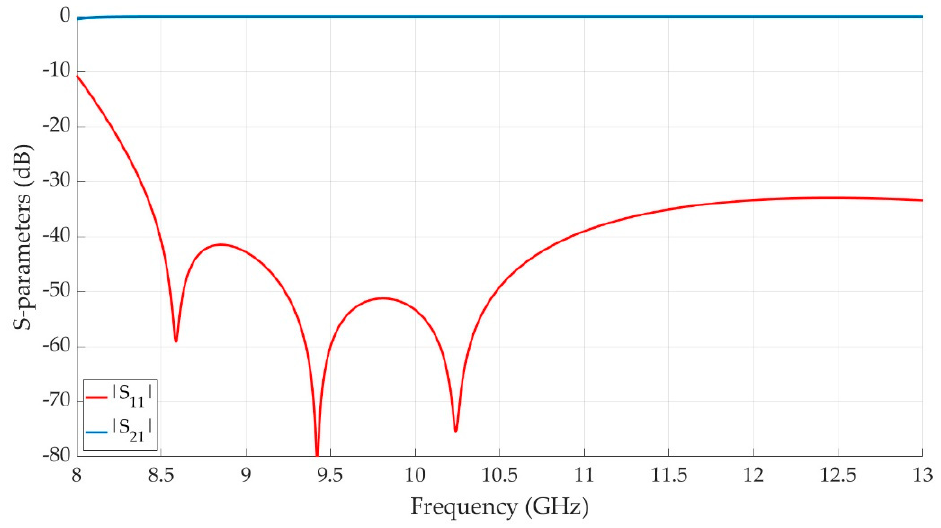
Figure 3. Groove gap waveguide scattering parameters.